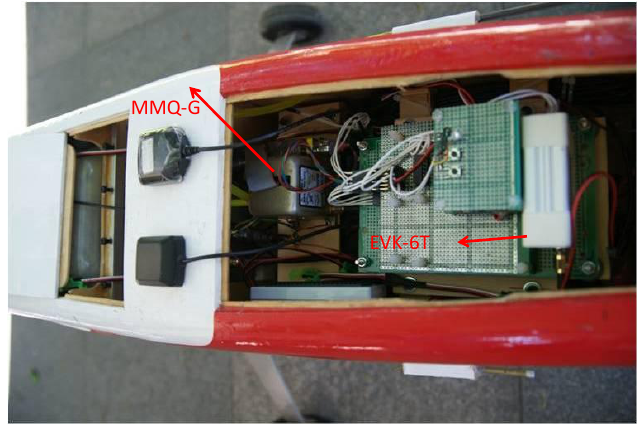
Figure 4. Set up of DG module in